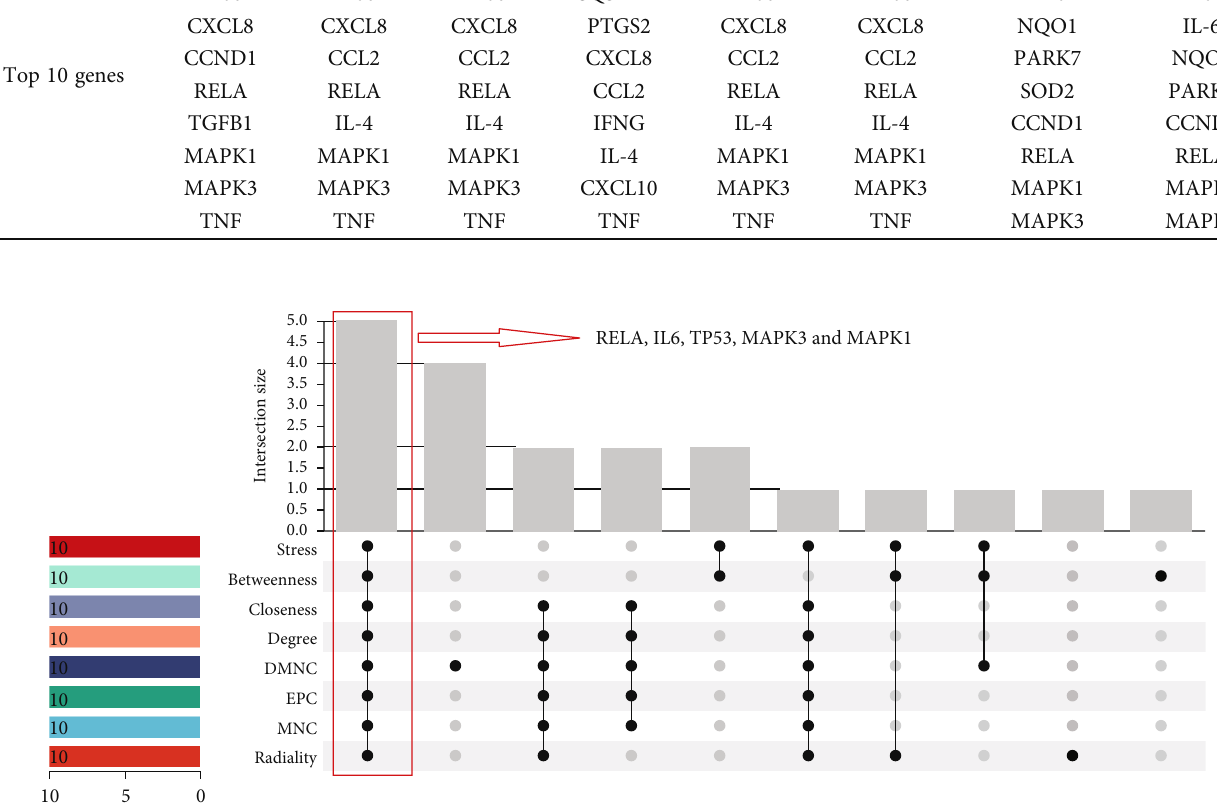
Figure 4: Identi fi cation of hub genes. Eight algorithms (stress, betweenness, closeness, degree, DMNC, EPC, MNC, and radiality) were used to identify hub genes based on R package “ UpSet. ”